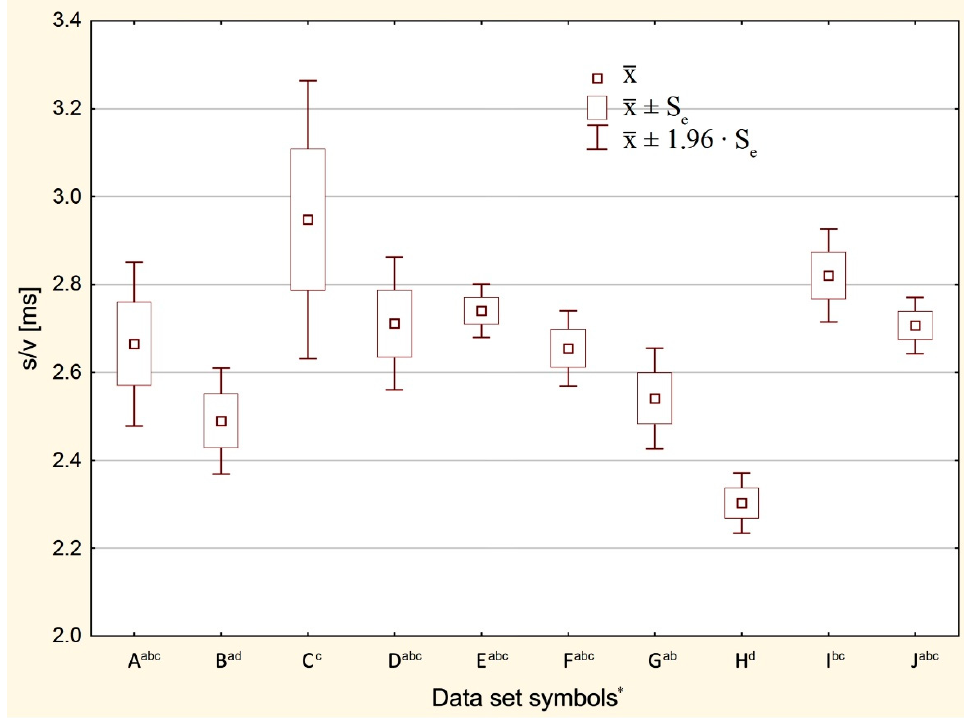
Figure 4. Statistical characteristics of values of s/v values by the data set (set symbols according to Table 2). *—DSS marked with the same letters do not differ significantly—Tukey test for different N ( α = 0.05).